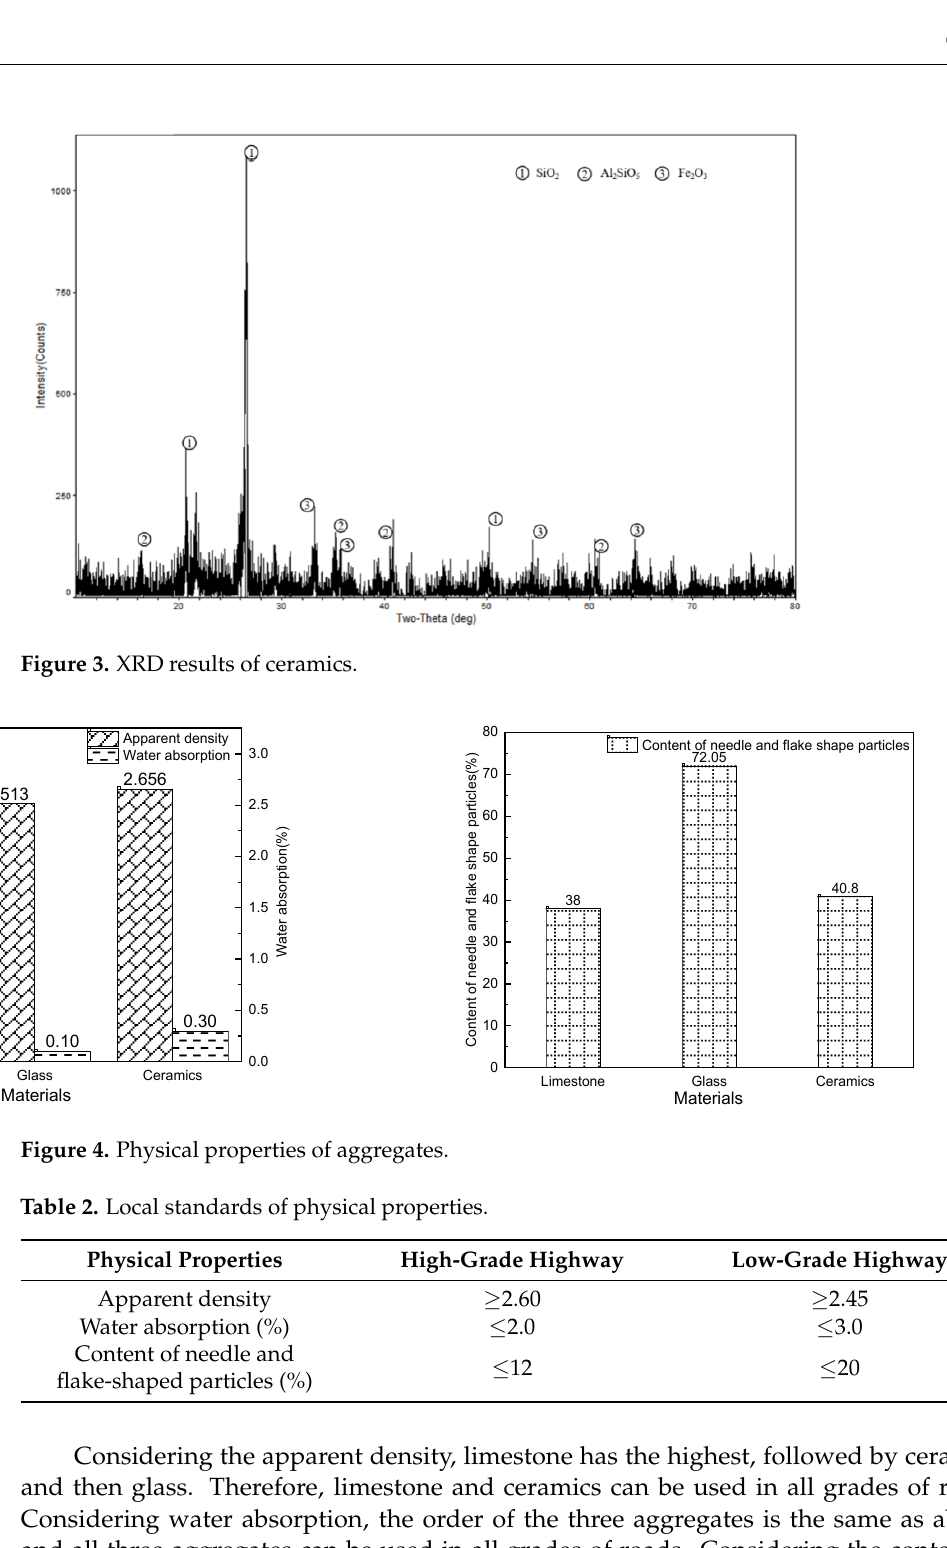
5 of 20 Figure 1. XRD results of limestone.